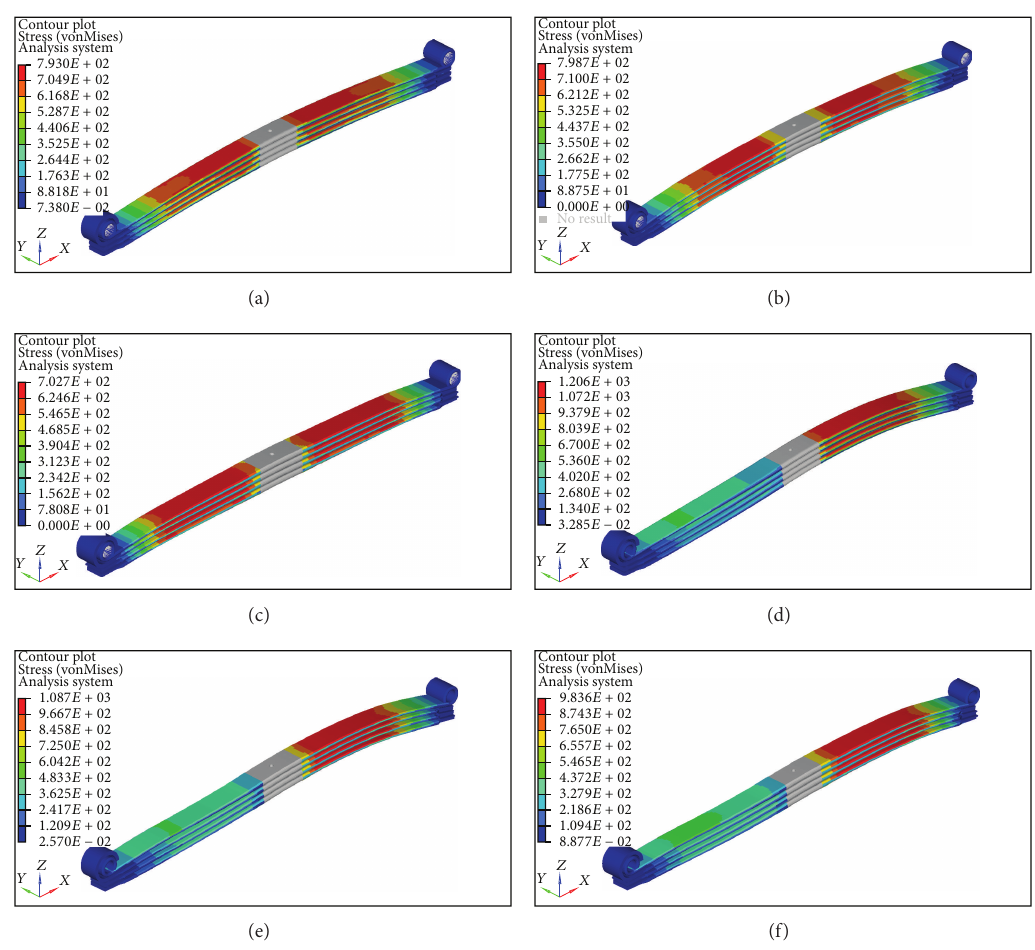
Figure 10: von Mises stress contour of parabolic leaf springs: (a) Baseline model vertical push, (b) Iteration 1 vertical push, (c) Iteration 2 vertical push, (d) Baseline model wind-up, (e) Iteration 1 wind-up, and (f) Iteration 2 wind-up.